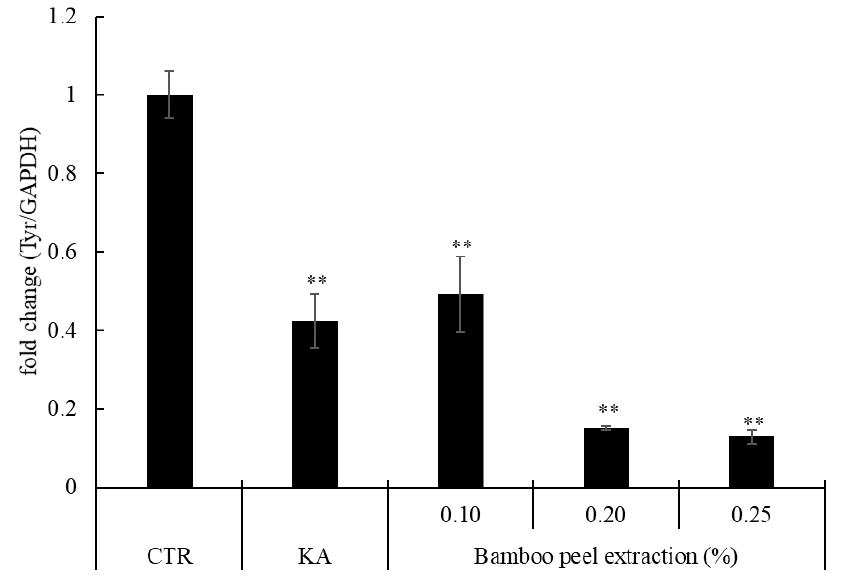
Figure 4. Relative amounts of tyrosinase gene expression after application of bamboo peel extract (** p < 0.01).